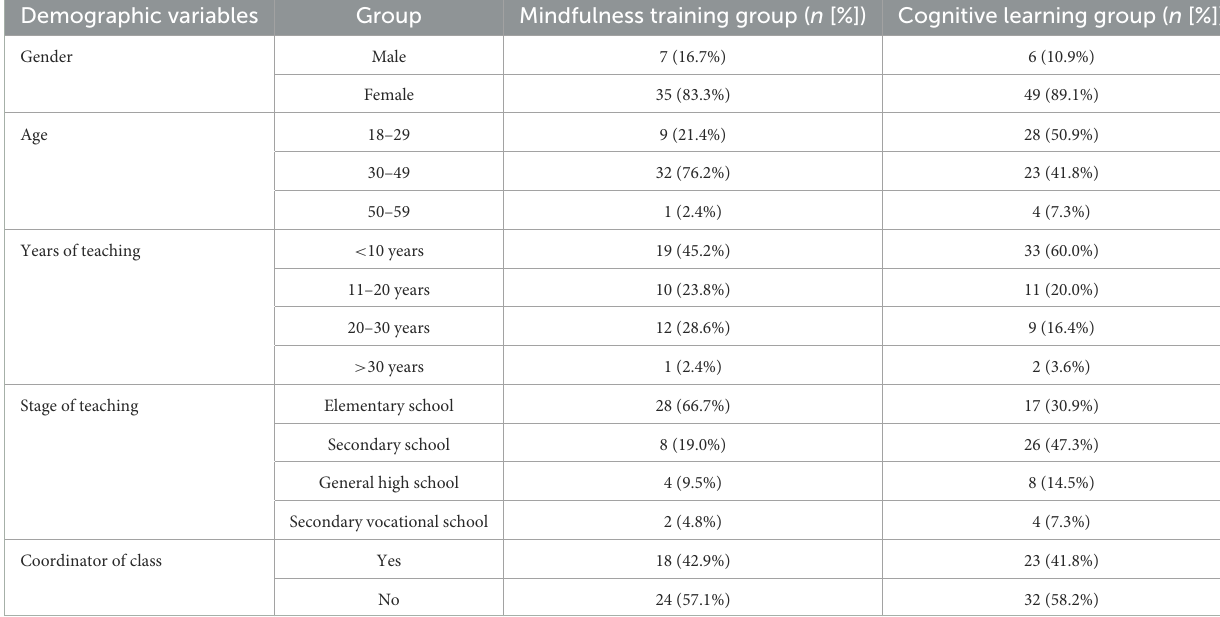
TABLE 2 Demographic characteristics of the participants in Phase